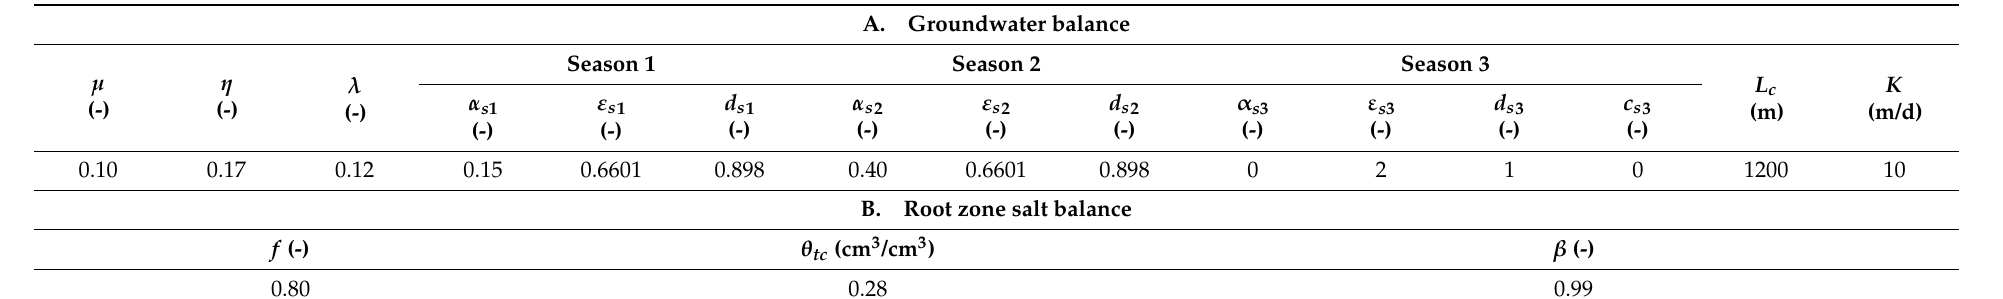
Table 5. Parameters of the developed model in the Longsheng well-canal conjunctive irrigation